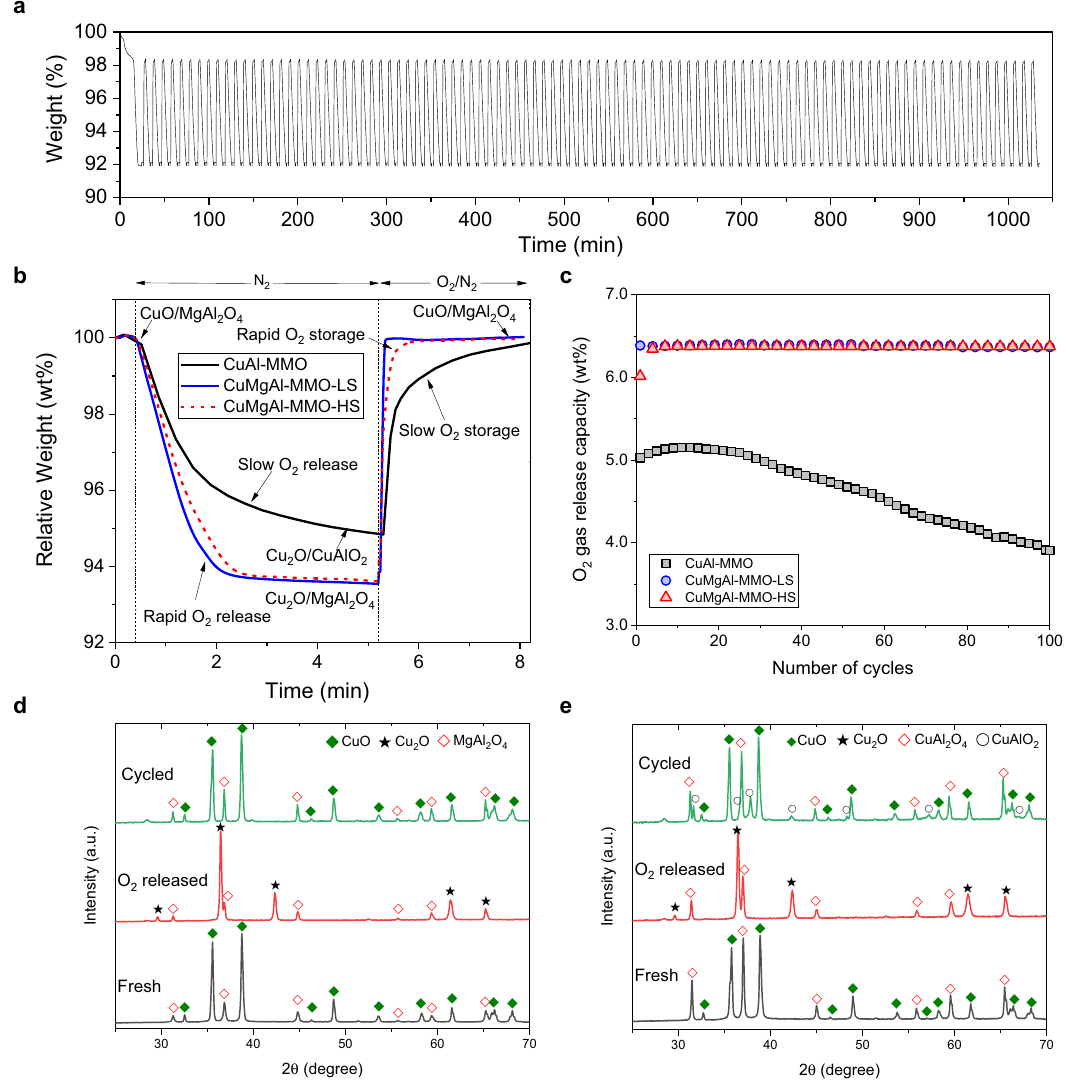
Fig. 5 | Redox cycling of oxygen storage materials in a TGA. a Weight change over100cyclesofO 2 release(CuOtoCu 2 O)underN 2 ofCuMgAl-MMO-LS. b weight change pro fi le during O 2 release under N 2 . Three typical samples were tested: CuAl-MMO, CuMgAl-MMO-LS (low strength), and CuMgAl-MMO-HS (high